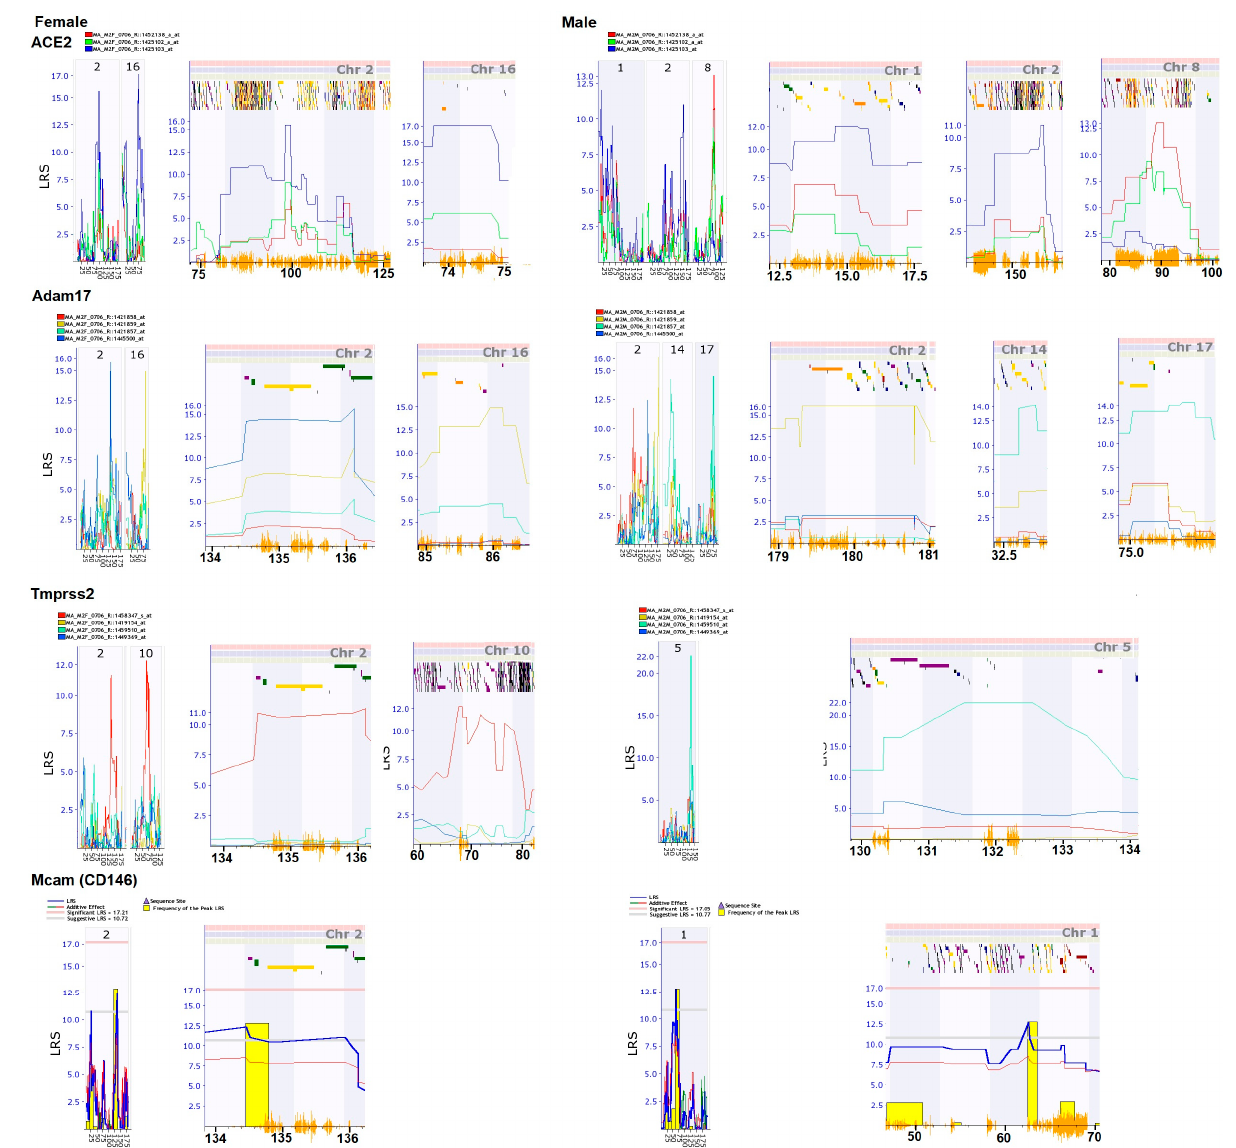
Figure 3. Expression QTL locations of Ace2 , Adam17 , Tmprss2 , and Cd146 in kidneys among female and male mice. The Y axis on the left of each mappi % figure are the levels of likelihood ratio statistic (LRS) of the QTL locus, while numbers under the axis at the bottoms are the genetic distance on the mapped chr. The small bars and dots of different colors on the top of each figure under the figure labels of female and male are the density of genes in the mapped region A positive additive coefficient (green line) indicates that DBA/2J alleles increase trait values. In contrast, a negative additive coefficient (red line) indicates that C57BL/6J alleles increase trait values. Yellow bars show the number of individuals contribute to the significance of the